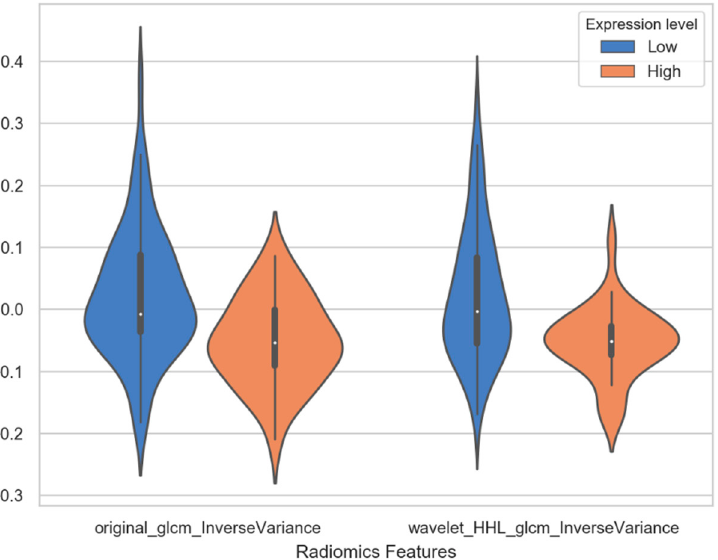
Figure 6. The violin plot of two radiomics features distributions between the high PD-L1 expression level group and low expression level group.